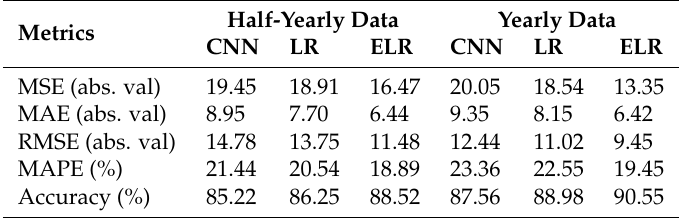
Table 18. Price performance metrics comparison for one month using the UMass Electric Dataset.